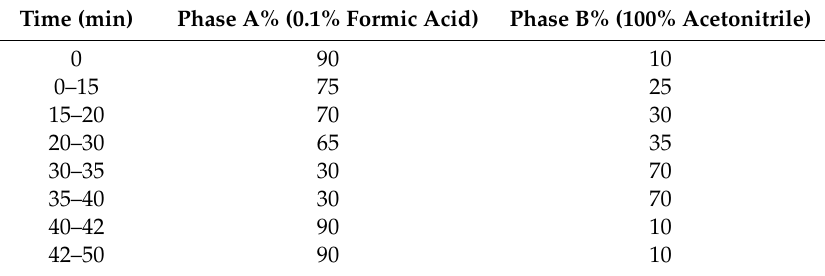
Table 1. Mobile phase elution